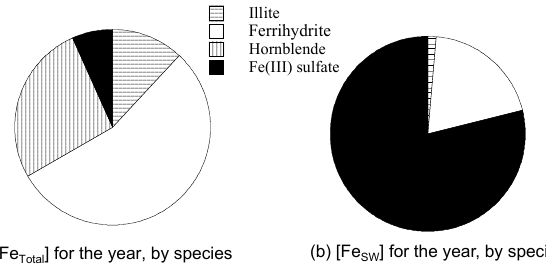
Fig. 13. Contribution of each Fe species to (a) total [Fe Total ] and (b) total [Fe SW ] for all the